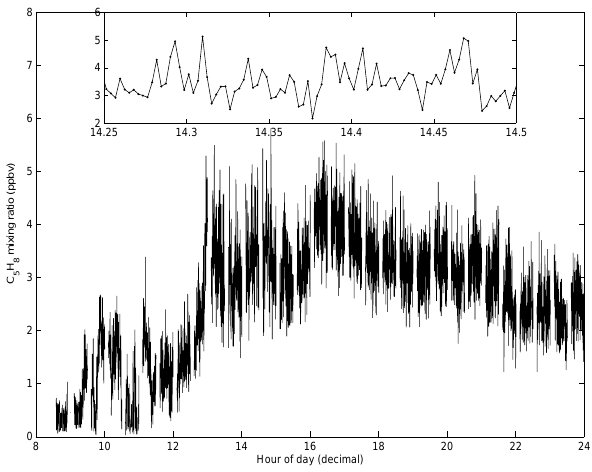
Fig. 1. Isoprene concentration data measured by PTR-MS for 26/04/08 showing 1 data point every 10s. The inset shows a 15min extract (note hours given as decimal fraction) indicating the short timescale over which large variations can